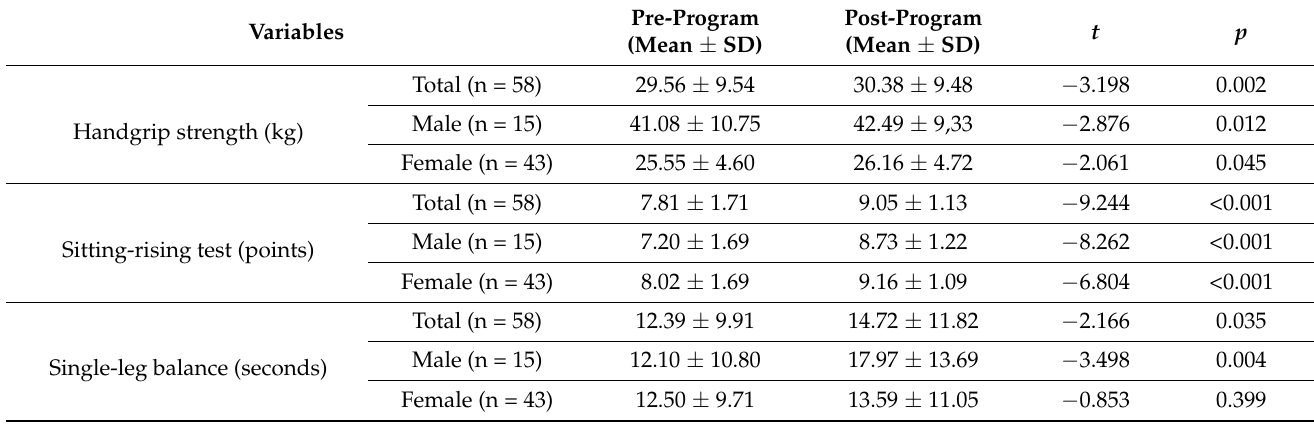
Table 5. Changes in physical fitness variables after 24 weeks of non-face-to-face